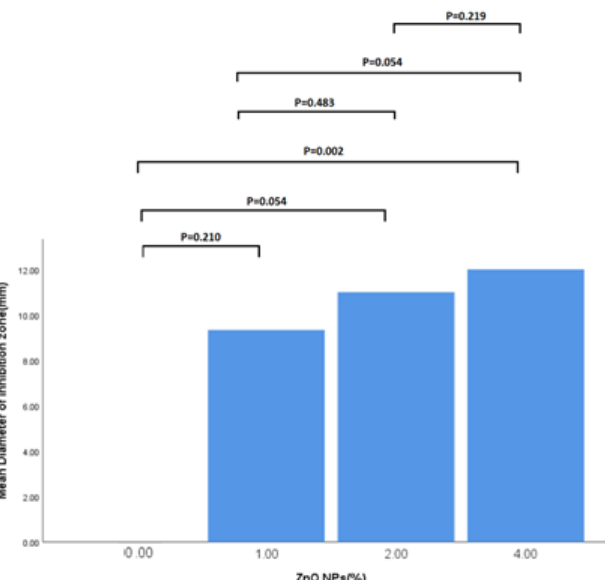
Figure 7. The results of the pairwise comparison test on the groups for the addition of ZnO NPs into the GIC.